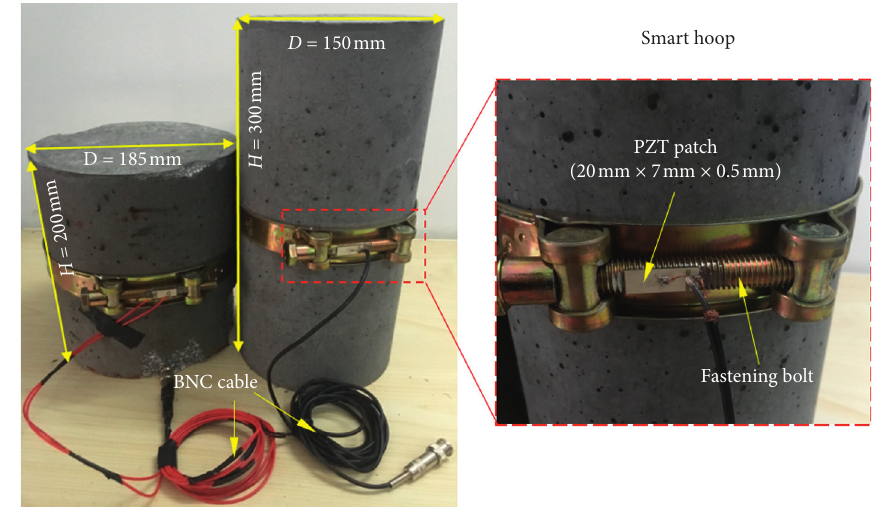
Figure 10: Dimensions of the concrete columns and the smart